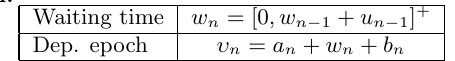
Figure 4: Time diagram of a multiplexer with 3 in- put ports and operating with a round robin arbitra- tion policy. FDES equations for the Single Server Model. Waiting time